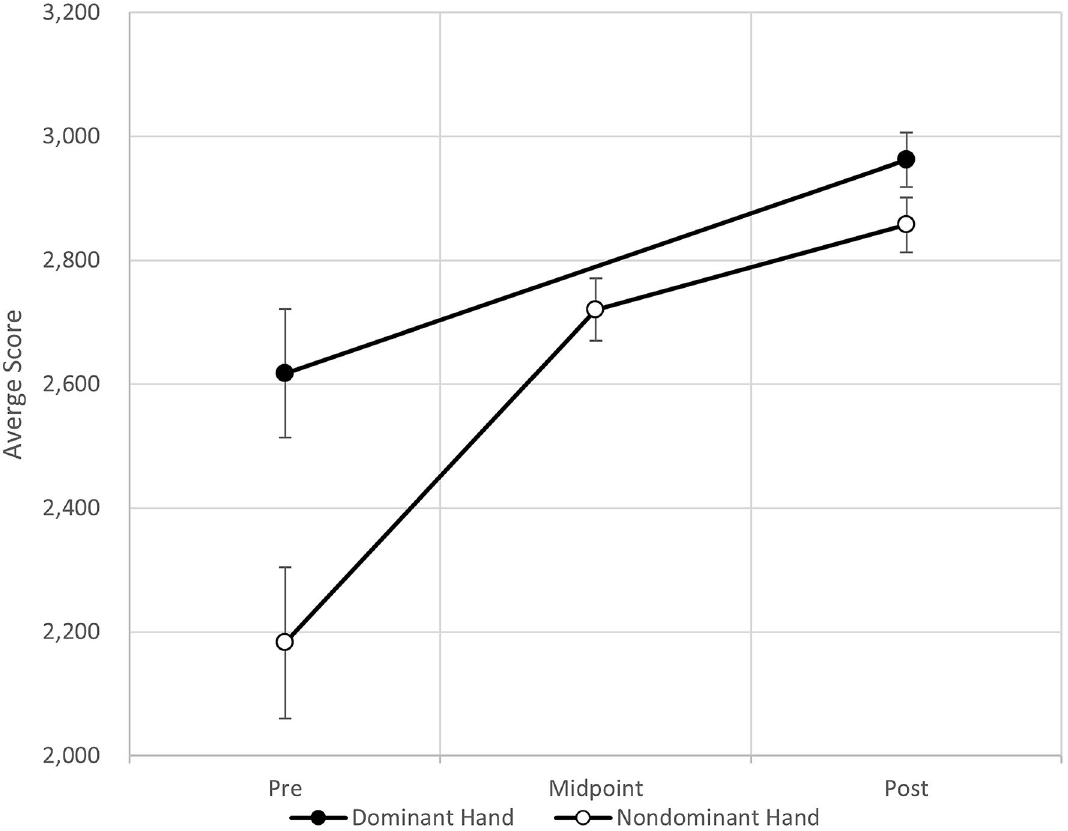
Figure 1. Mean values and standard errors for scores with the dominant and nondominant